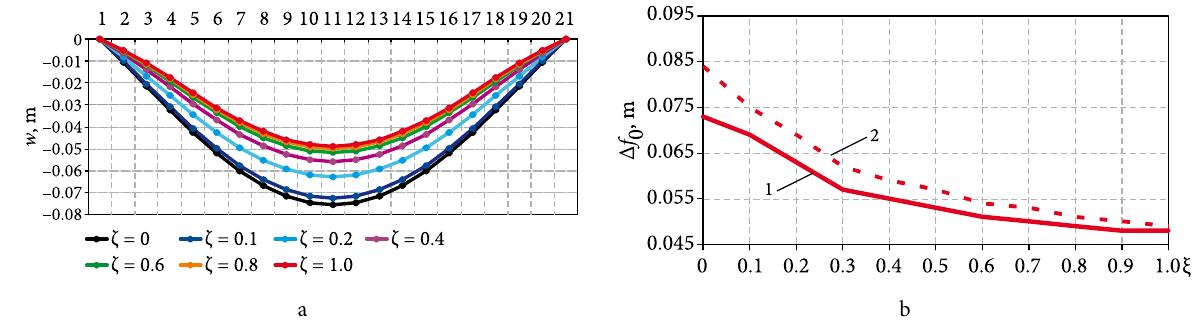
a b Fig. 3 . Vertical displacement curves (a) and mid-span deflection (b) of the stiffening girder under symmetrical loading (γ = 1): 1 − two-hinged cable; 2 − three-hinged cable